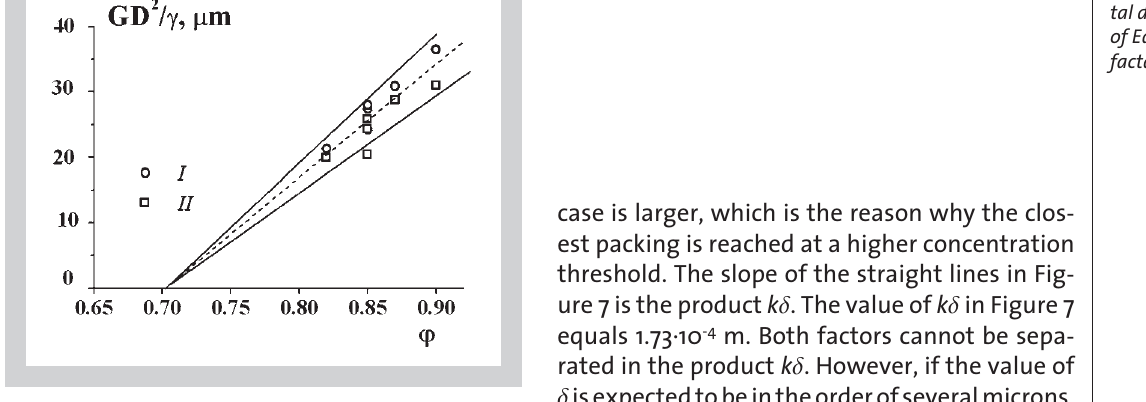
Figure 7: Presentation of experimen- tal data in the coordinates of Eq. 13 (I and II – two sur-